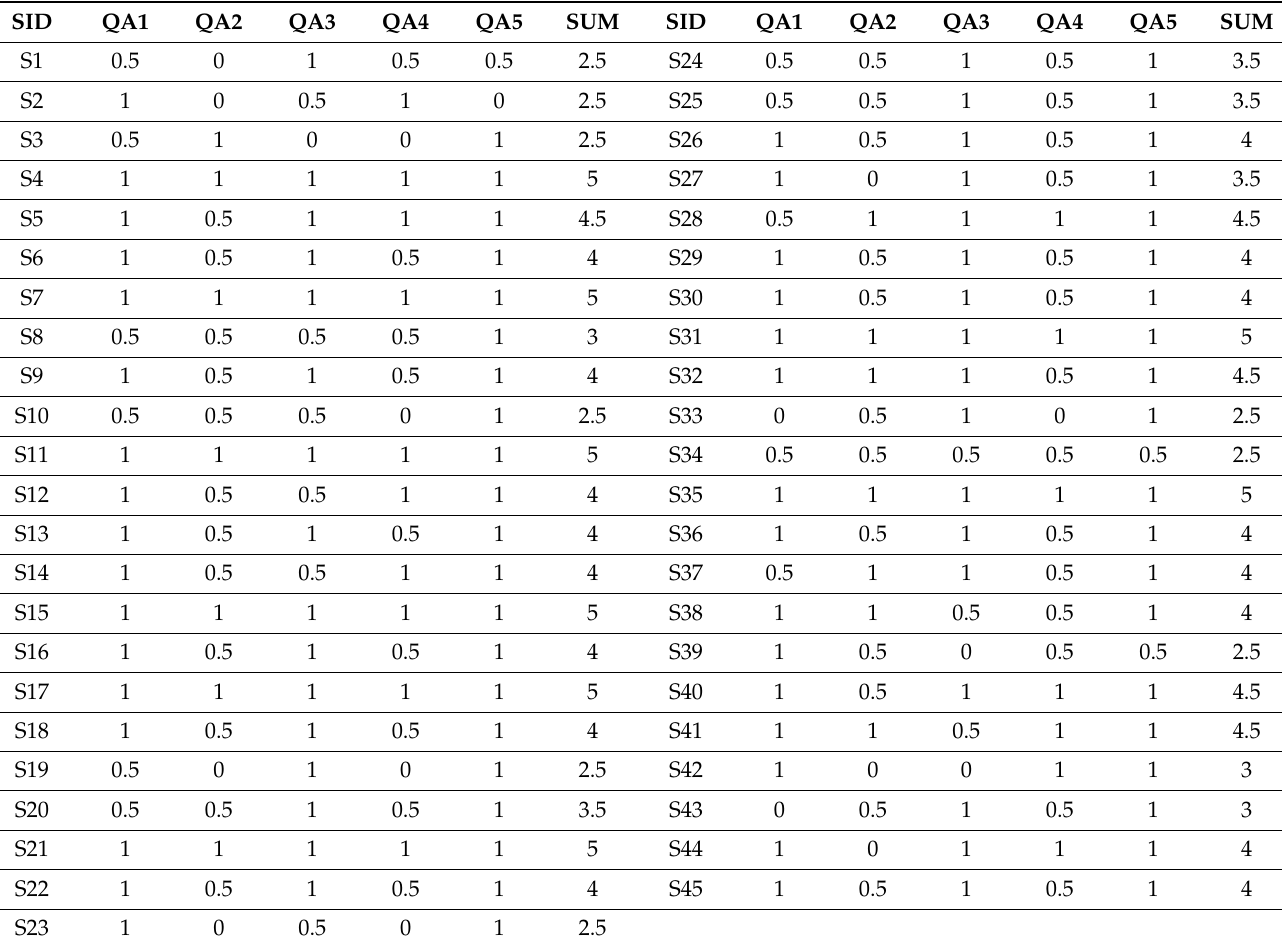
Table 4. Quality Assessment scores of primary